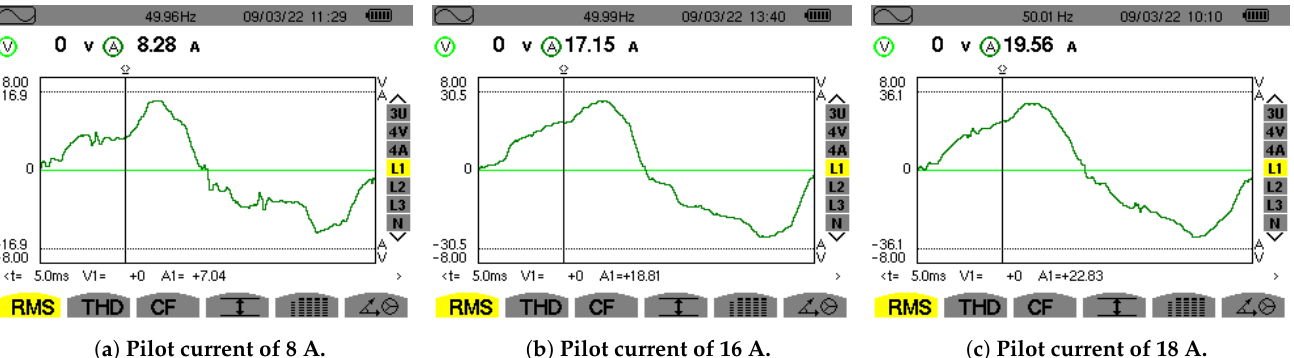
Figure 5. Measured charging profile of the EV.